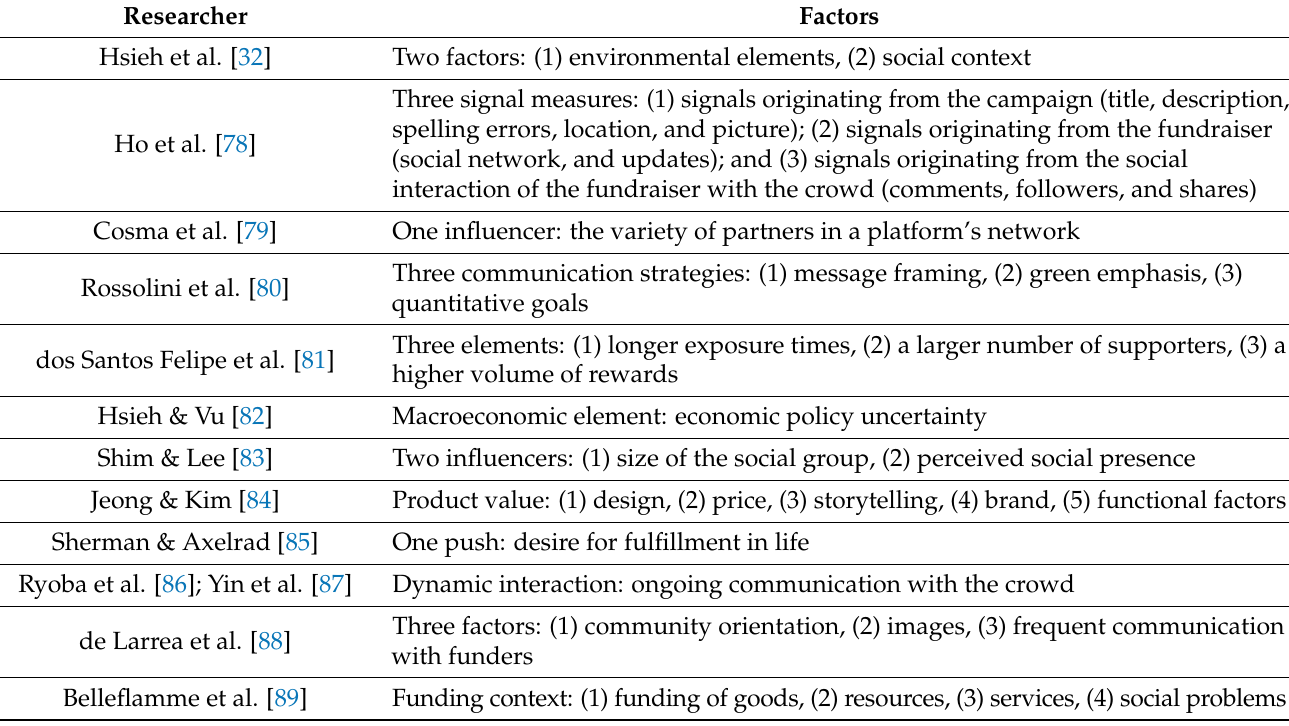
Table 2. Factors affecting crowdfunding